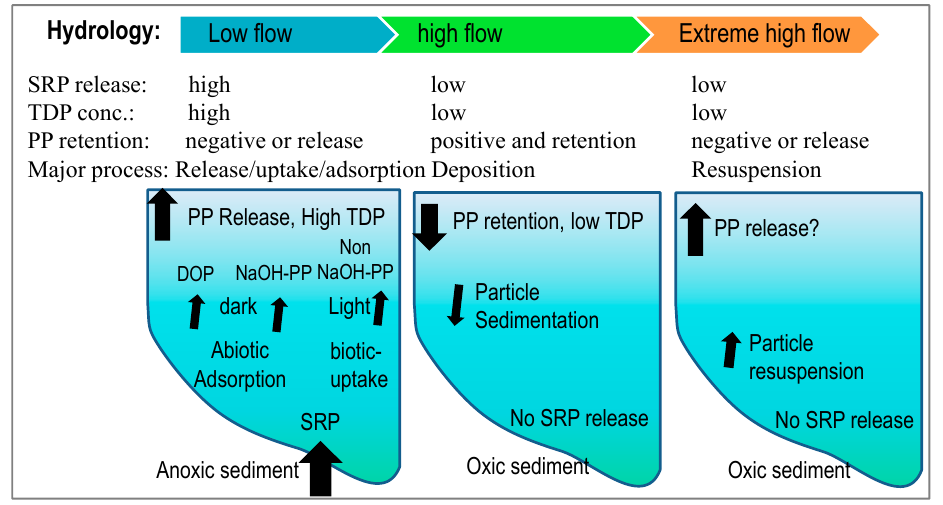
Figure 7. A conceptual diagram showing dominant physical and biogeochemical processes and possible effect on P retention in urban SCMs during across stream flows.